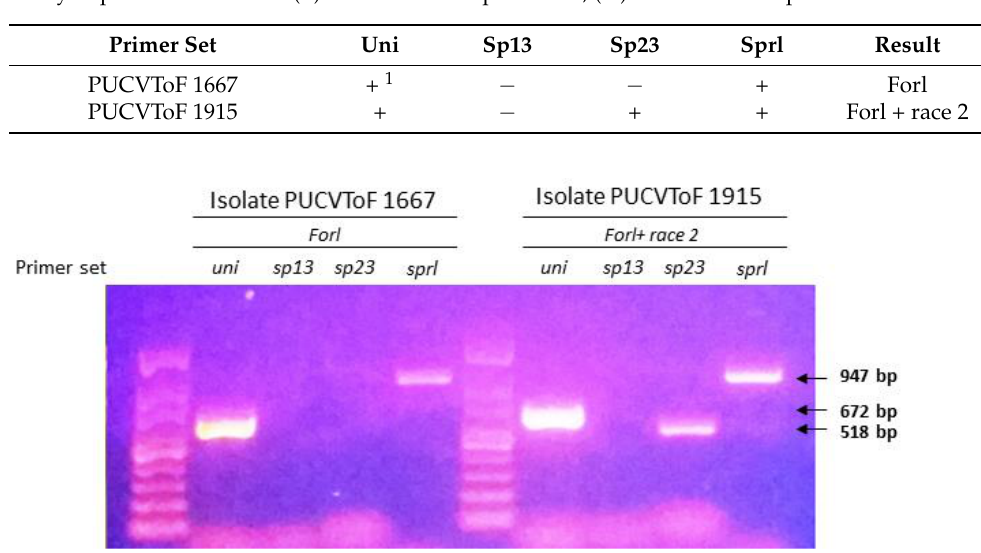
Figure 1. Identification of isolates PUCVToF 1667 and PUCVToF 1915 by polymerase chain reaction (PCR) with the uni, sp13, sp23, and sprl primer sets [37]. PCR products were electrophoresed in a 1.0% agarose gel and stained with red gel. The arrows show the size of the amplicons obtained.